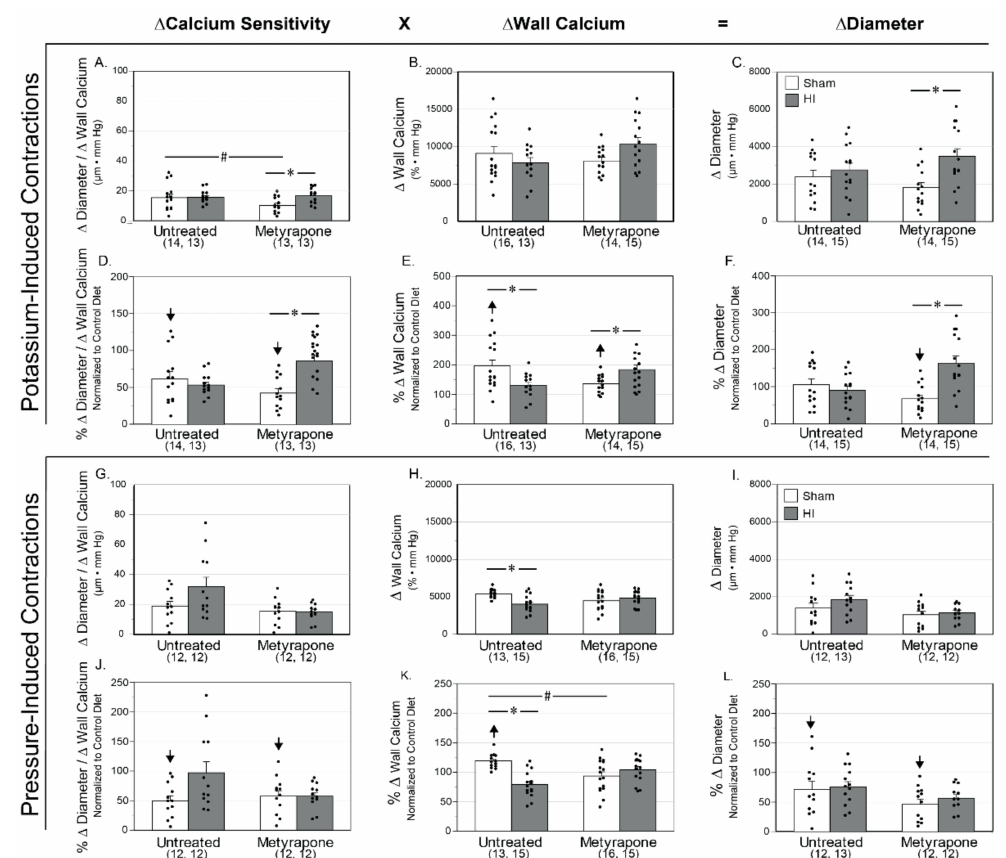
Figure 6. Effects of HI, gestational MET, and MUN on changes in diameter, wall calcium, and calcium sensitivity induced by K+ and pressure in MCA in P11/P12 pups. Middle cerebral artery measurements of contractile responses to changes in intraluminal pressure enabled assessment of responses in PSS with 120 mM K+ ( A–F ) and in PSS alone ( G–L ). Plots of these changes against intraluminal pressure on the abscissa allowed calculation of the areas beneath the curves for three different parameters on the ordinate: outside diameter ( ∆ Diameter), which is a product of wall calcium concentration ( ∆ wall calcium) and calcium sensitivity ( ∆ Diameter/ ∆ wall calcium). ( A–C , G–I ) Columns and error bars indicate SEM overlaid with a dot plot of individual values and show difference between MUN groups. ( D–F , J–L ) Columns and error bars indicate MUN values normalized to CD for each response and show MUN-induced effects. ANOVA with a post-hoc Fisher’s LSD determined the statistical significance as shown by: * for differences between Sham and HI groups and # for differences between MET-Sham and Untreated-Sham groups. Refer to Figure 4 for a description of the statistical symbols and n values shown